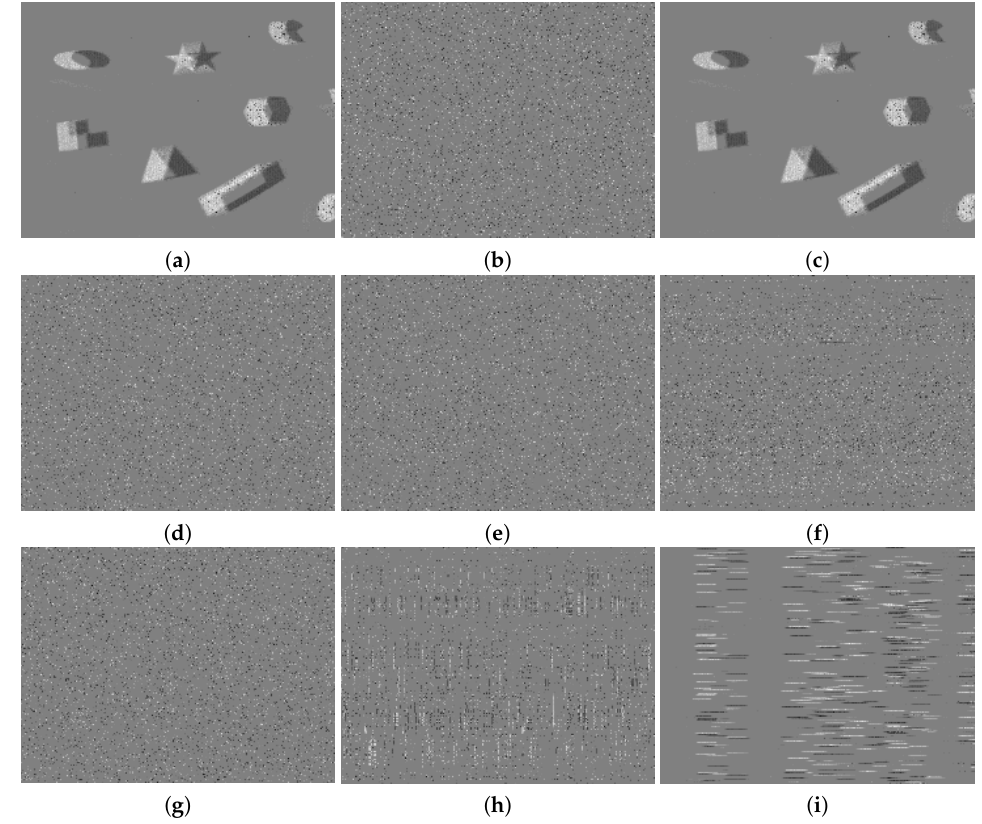
Figure 9. The sensitivity study on the secret keys. ( a ) The original event image. ( b ) The event image after encryption. ( c ) The event image after decryption with the correct secret key K 0 . ( d – i ) The event images after decryption with incorrect secret keys K 1 , K 2 , K 3 , K 4 , K 5 and K 6 , respectively. The time ( µ s) spent on encrypting each event is measured and listed in Tables 3–5. When the updating score was 7.2, the average time to encrypt one event was less than 0.60 µ s on Raspberry Pi. When the updating score increased to 8.4, encrypting one event only consumed about 0.20 µ s on Raspberry Pi, and only 0.04 µ s on both desktop and cloud servers. The numbers of processed events per second with different updating scores are demonstrated in Figure 10. On the Raspberry Pi, more than tens of millions of events could be encrypted per second. These experimental results indicated that the proposed encryption framework worked efficiently on various platforms, including resource-constrained devices. Table 3. Time ( µ s) spent on encrypting one event on Raspberry Pi ( K = 36,694,061) using different updating scores and NVSs with different